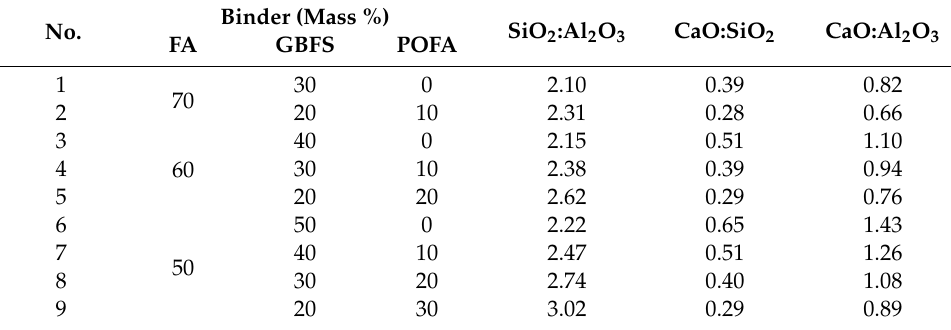
Table 2. Contents of constituents in the high volume of FA mix design.